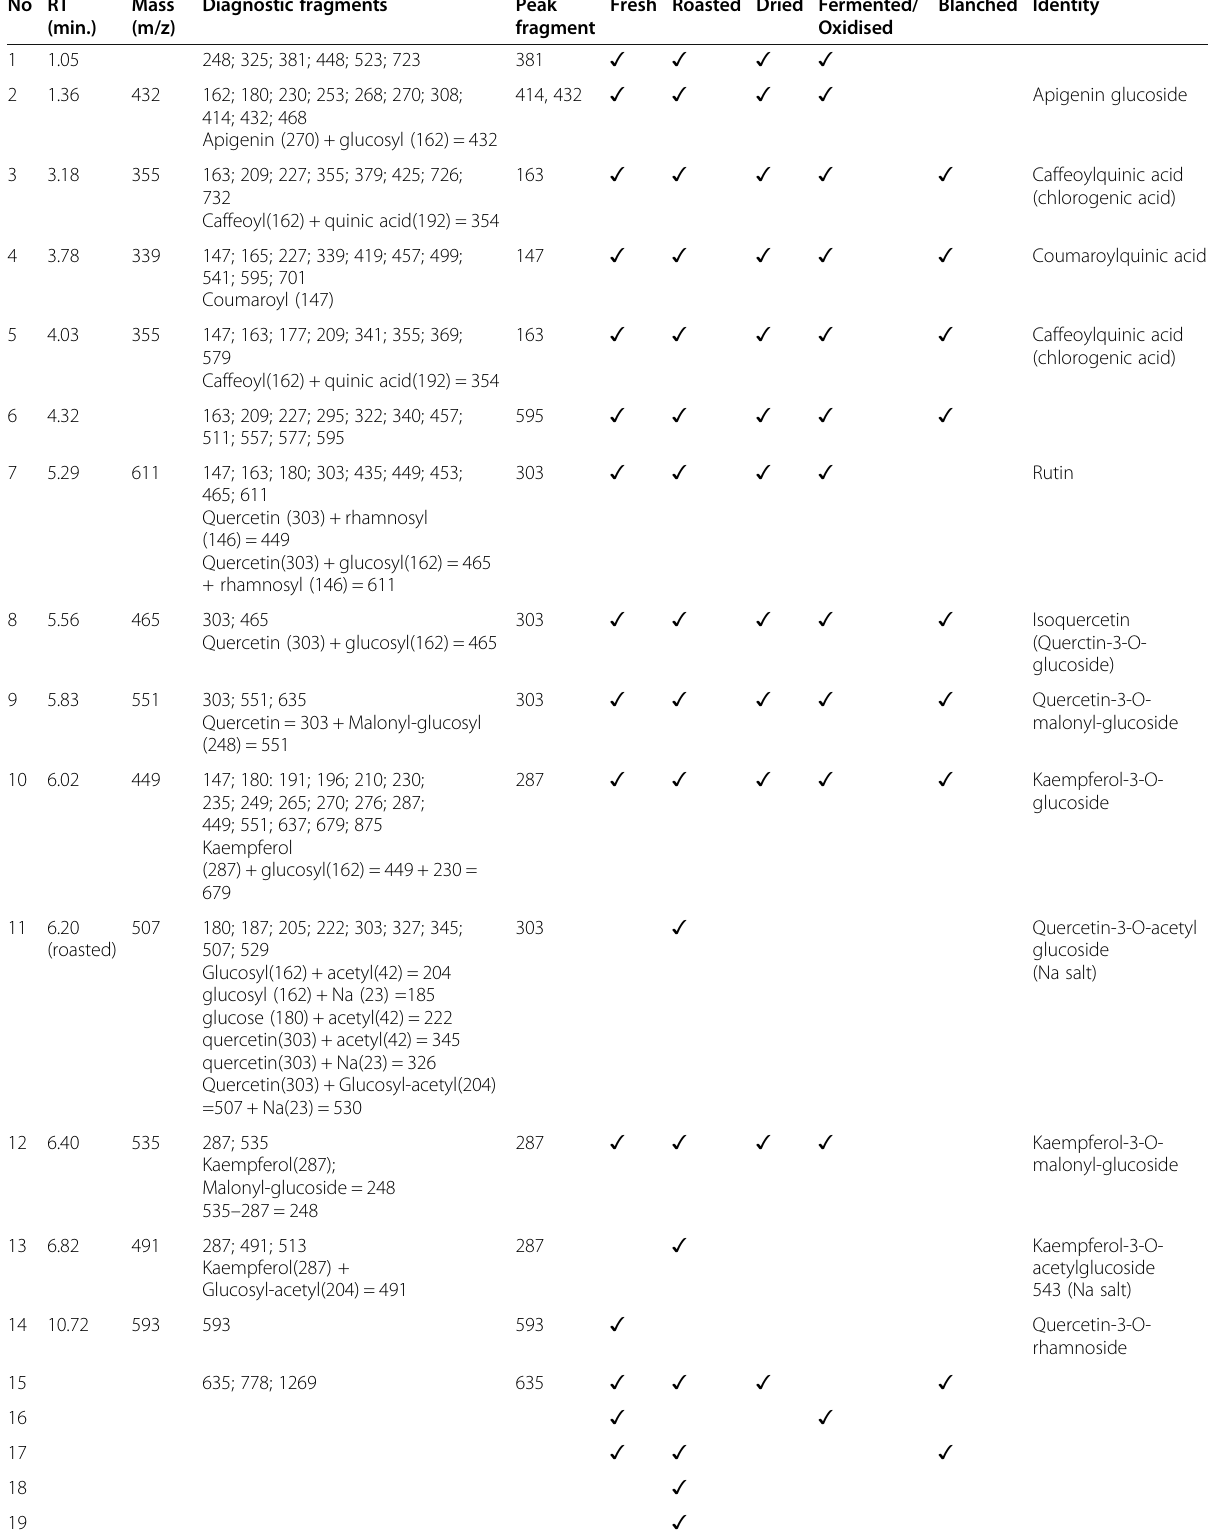
Table 7 Tentative identification of main polyphenols in chromatographs of Moringa oleifera fresh and processed Leaf Extract No RT